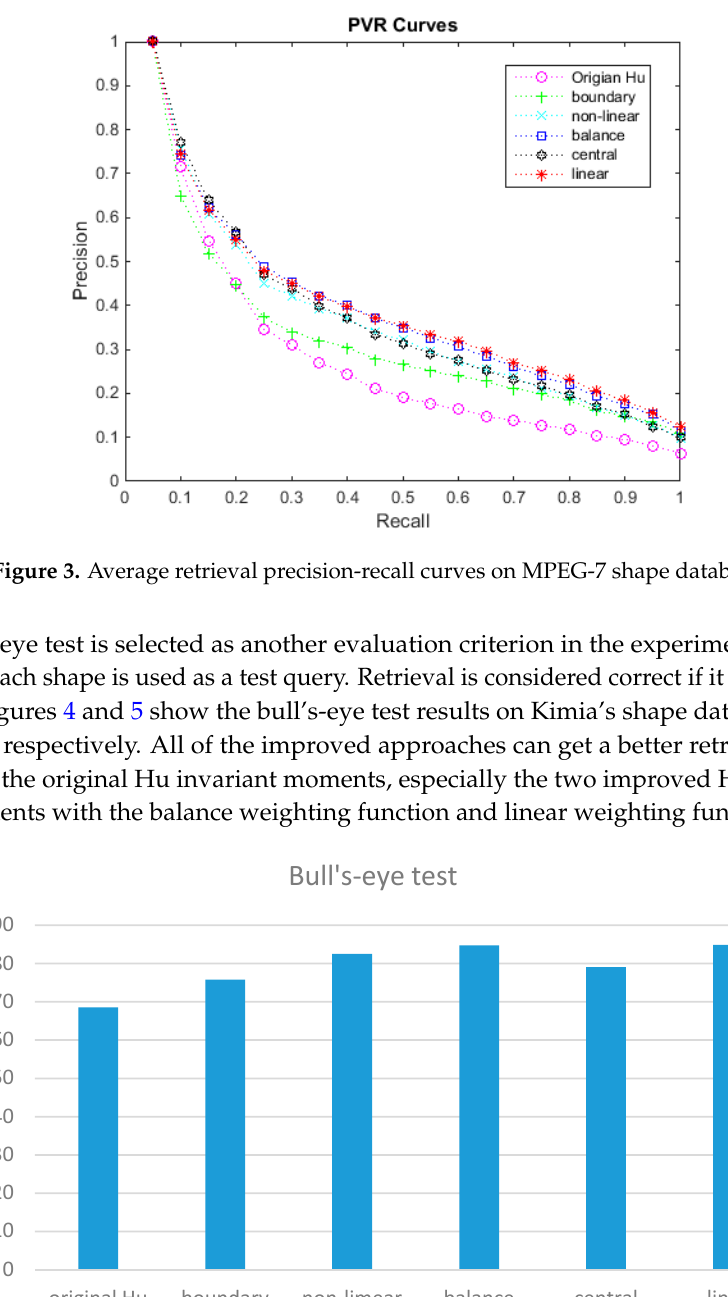
Figure 3. Average retrieval precision-recall curves on MPEG-7 shape database.